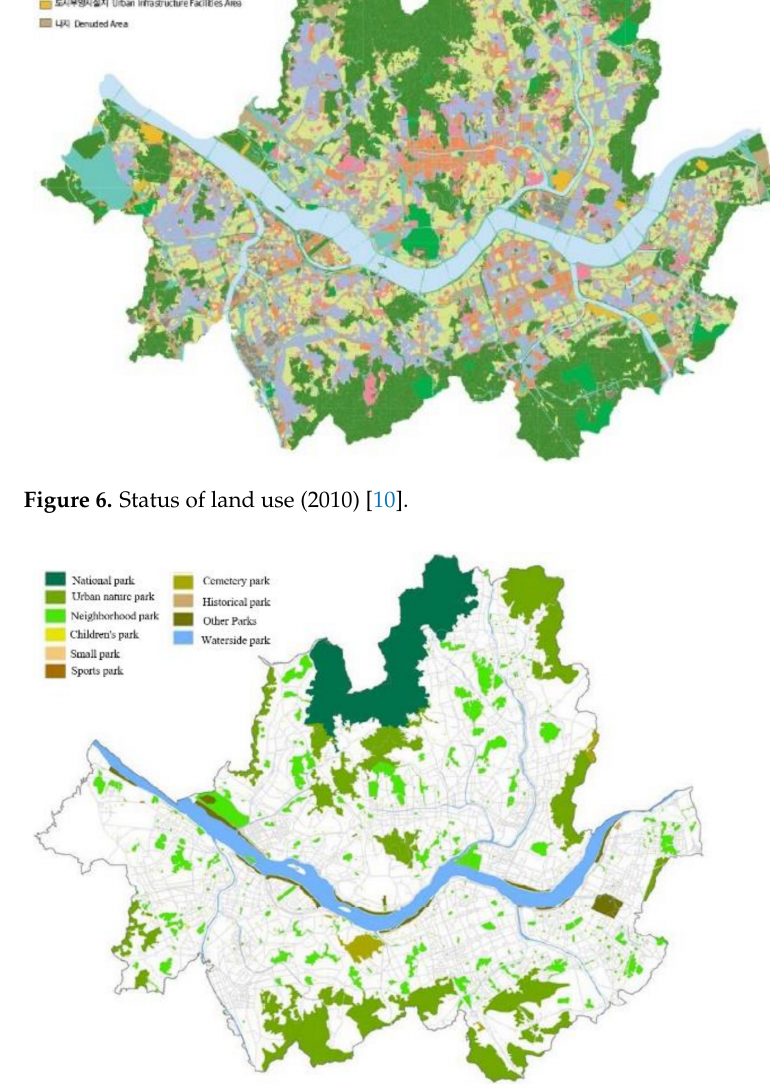
Figure 7. Current status of parks and green space in Seoul